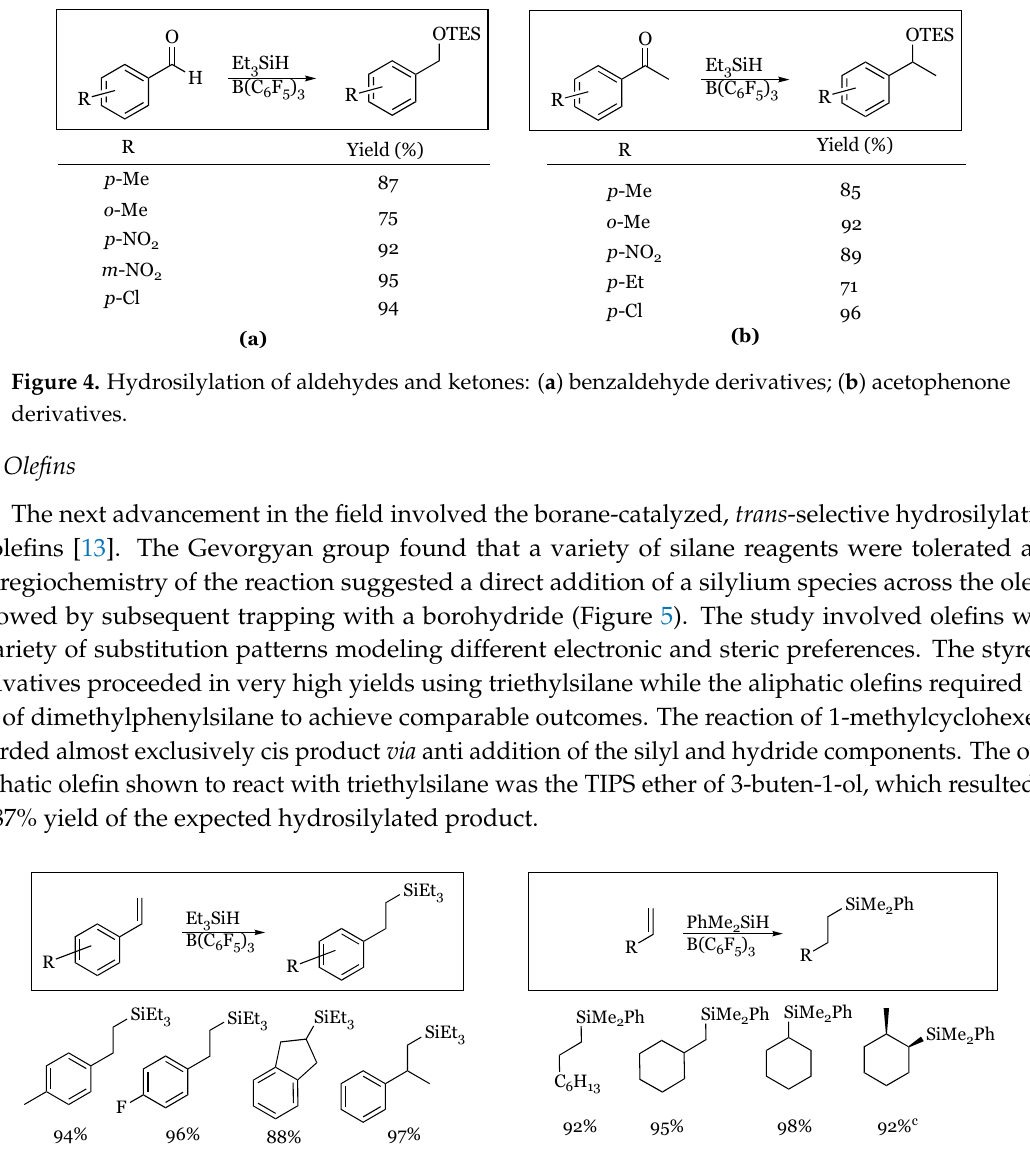
Figure 6. Conversion of carboxylic acids into aldehydes: ( a ) aliphatic carboxylic acids; ( b ) aromatic carboxylic acids; * Triethylsilane used in place of triphenylsilane.